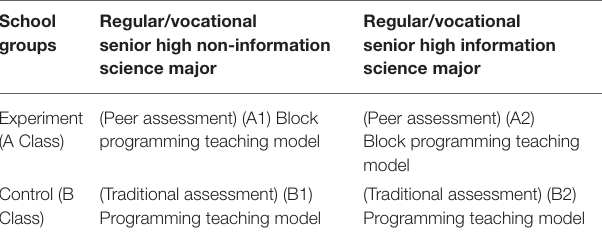
TABLE 1 | Experiment group and control group for research hypotheses.